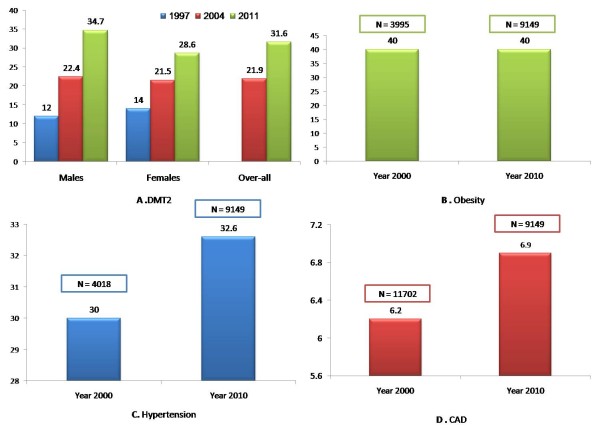
Trends in the prevalence of chronic noncommunicable diseases in the Kingdom of Saudi Arabia from 2000 to 2010. (A) Age-adjusted prevalence of type 2 diabetes mellitus in Saudi Arabia according to gender (1997 [36], 2004 [7], 2011 (present study)). (B) Coronary artery disease. (C) Hypertension. (D) Obesity. Previous estimates shown are from the central region (Riyadh) and do not include other regions.